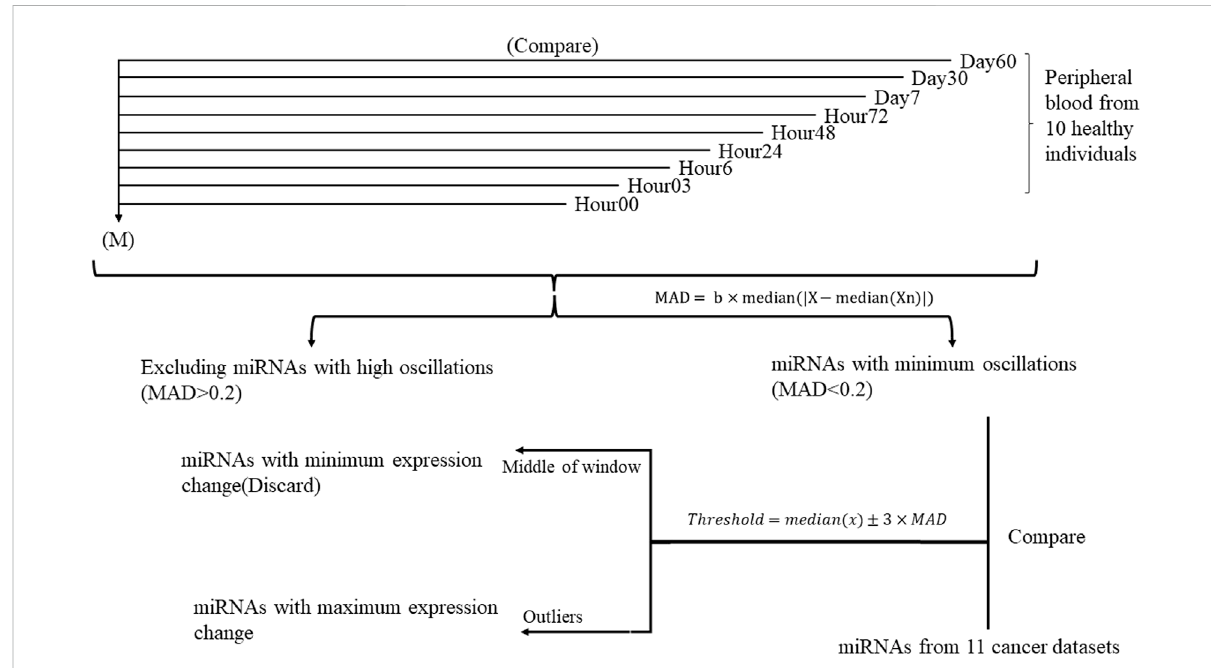
FIGURE 1 Study design fl owchart performed on ten healthy individuals throughout nine time points. Each time point is compared to the mean of expression of 90 samples during nine timepoints (M) separately. miRNAs with similar expression in all time points were selected for further